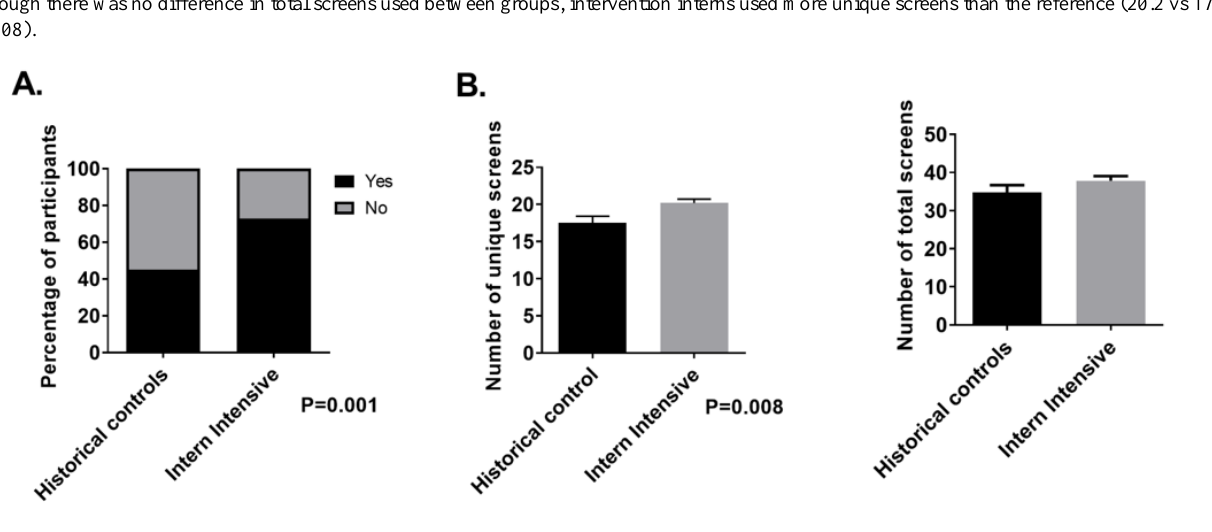
Figure 4. Percentage of reference subjects and intervention interns using high-yield screens and participant self-reported use of high-yield screen 6 months after the intervention. The reference residents (N=62) and intervention interns with available data (n=70, 99%) had data gathering navigation patterns during the independent learning portion of the simulation recorded. Intervention interns used 8 of 13 high-yield screens more frequently by Pearson chi-square as denoted by * P <.05. Intervention interns responded to a survey querying the continued use of high-yield screens 6 months after the lesson (n=35, 49%), with qualitatively maintained uptake. I/O: Intake/output; ICU: intensive care unit; MAR: Medication Administration